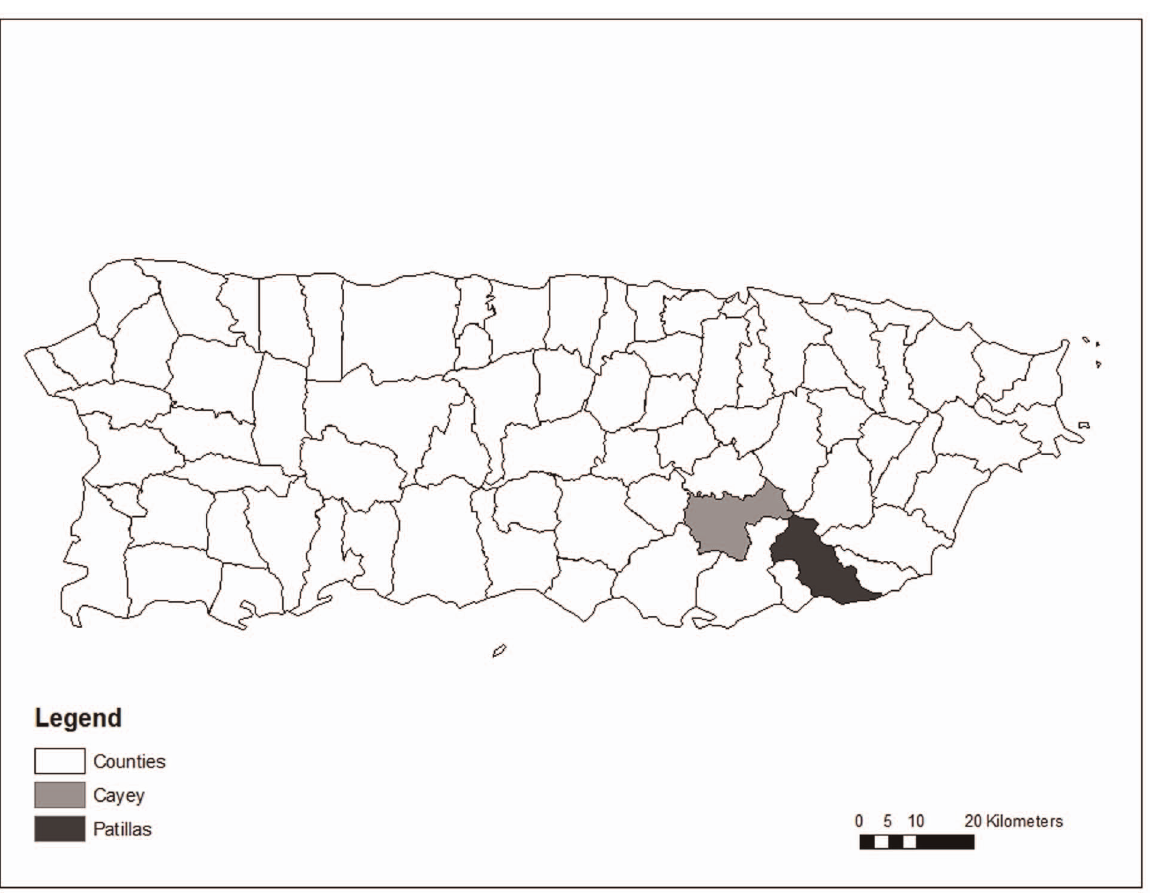
Figure 1. Map of Study Region in Puerto Rico. Municipalities where surveys were conducted are highlighted in gray. We did not list specific communities that we visited to keep the communities we surveyed